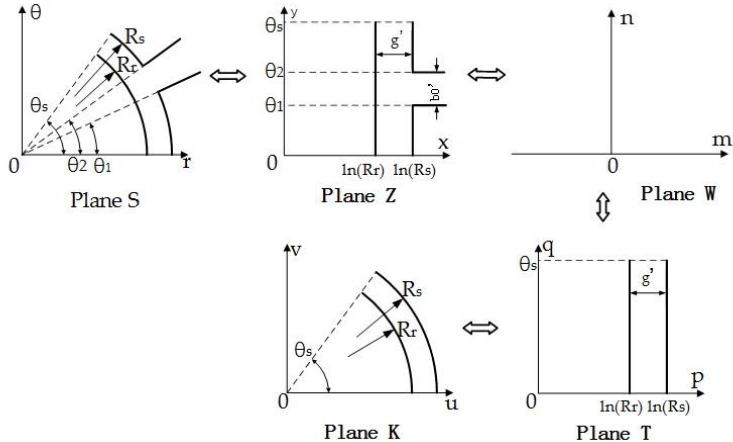
Figure 10. The process of conformal mapping.